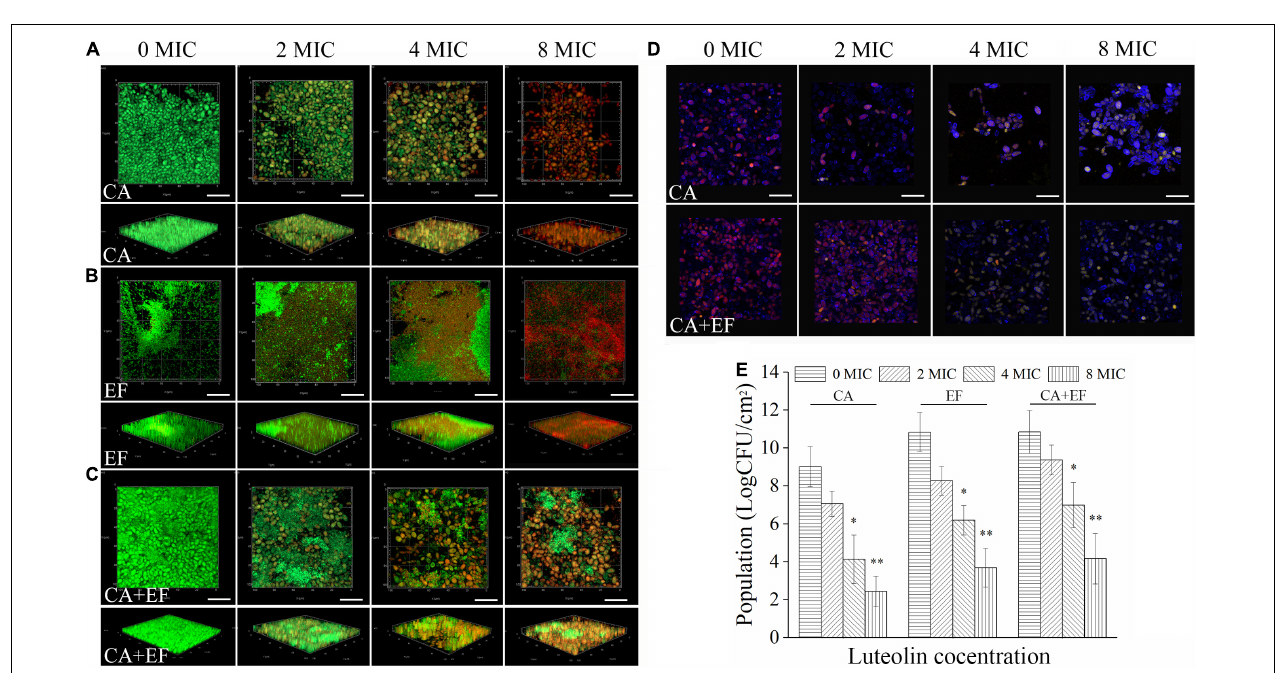
FIGURE 7 | Assessment of the killing effect of luteolin on biofilm cells of C. albicans SC5314 (CA) (A) and E. faecalis 20033 (EF) (B) single and dual species (CA + EF) (C) via confocal laser scanning microscope (CLSM). Representative CLSM photographs of plane and three-dimensional luteolin-treated biofilms were displayed. Viable and non-viable biofilm cells were examined by SYTO 9 (green) and PI (red), respectively. Metabolic activity assay of C. albicans SC5314 cells within biofilms by luteolin-treated single and dual species (D) (scale bars of 20 µ m). Red fluorescences represent the viable channel of fungal cells; yellow-green fluorescences stand for the non-viable channel of fungal cells. The number of viable cells within biofilms by luteolin-mediated C. albicans SC5314 and E. faecalis 20033 single and dual species was evaluated by the viable cell counting method (E) . ∗ p < 0.05; ∗∗ p < 0.01.